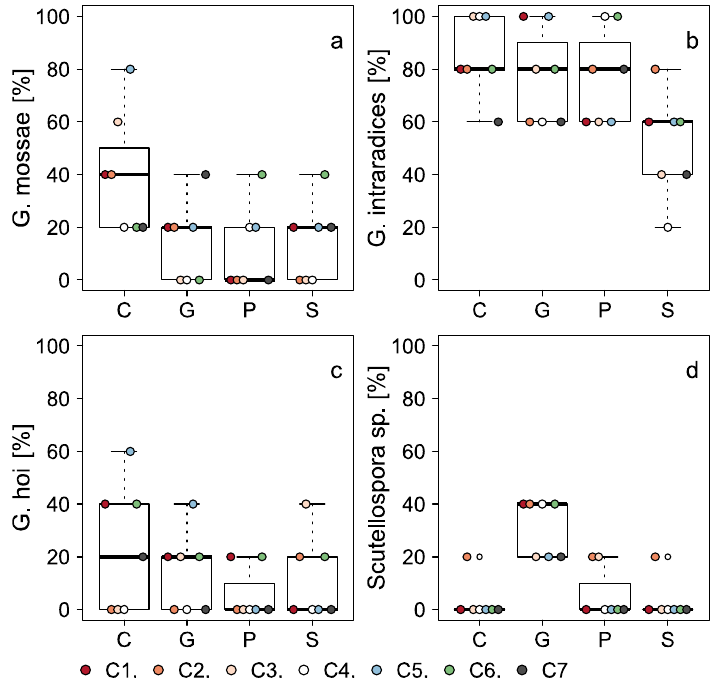
Figure 5. AM diversity ((%) in 10 cm root length) in the four soils originating from different land use types (C = cornfield, G = grassland, P = poplar soil, S = spruce soil) and the seven poplar clone types: C1 = P. nigra (clone Fritzlar 2 Maserpappel); C2 = P. deltoids ; C3 = P. nigra × P. maximowiczi (clone Max 3); C4 = P. trichocarpa ; C5 = P. maximowiczii ; C6 = P. canadensis (clone ROBUSTA); C7 = P. maximowiczii × P. trichocarpa (clone Hybrid 275